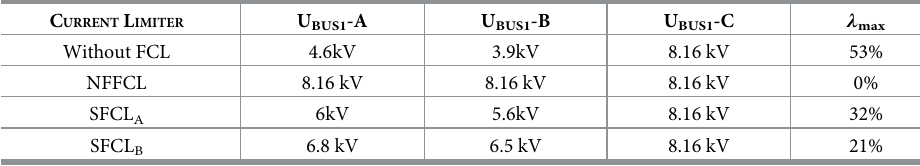
Table 4. Comparison of 2LG FRT transient